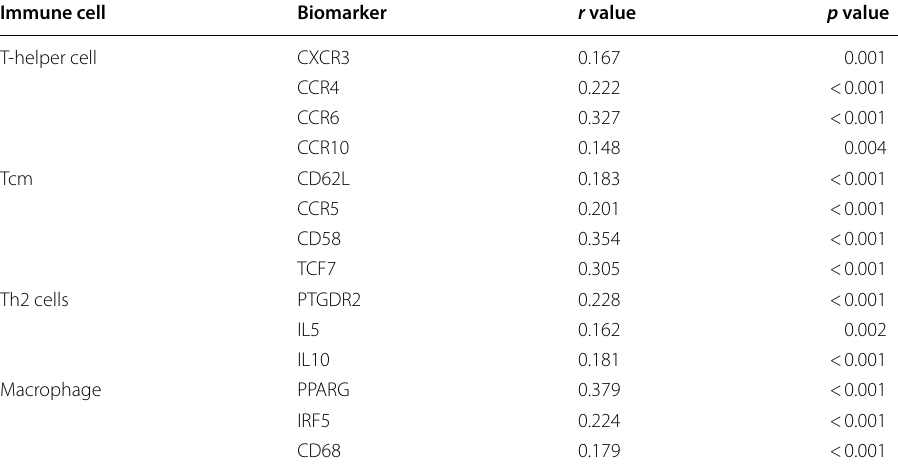
Table 2 The association of ROBO1 expression with the biomarkers of immune cells Immune cell Biomarker r value p value T-helper cell CXCR3